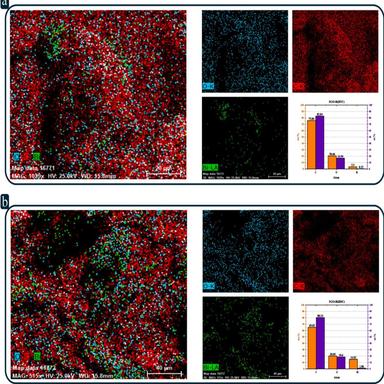
Elemental mapping images (EDX mapping) related to (a) FGO-Bi(BTC) and (b) FGO-Bi(BDC).